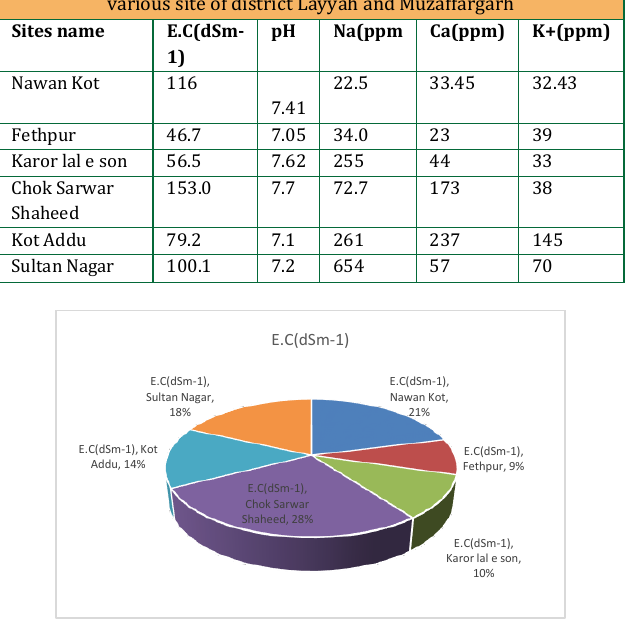
Figure 13: EC (dSm-1) of different sites of districts Muzaffargarh and Layyah.